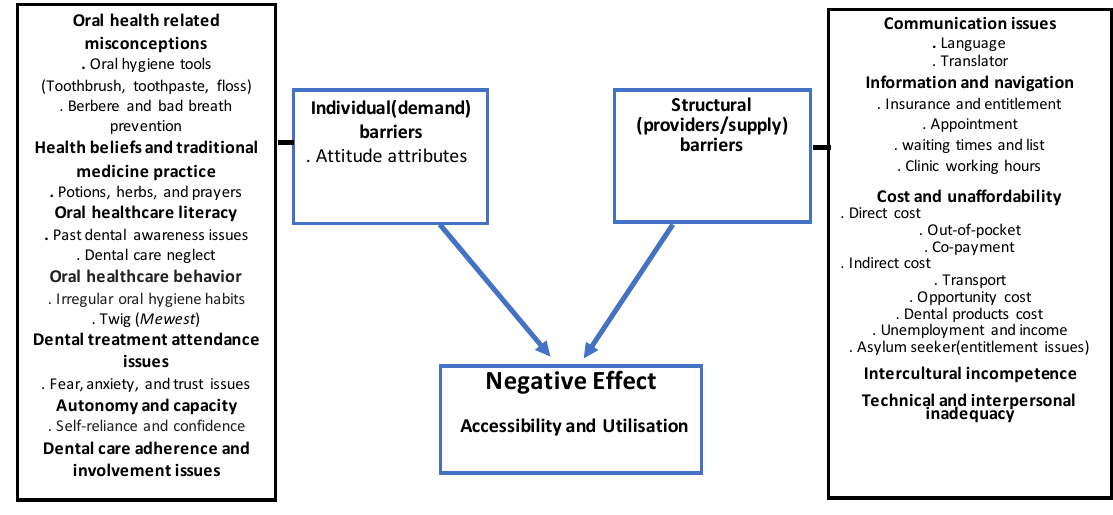
Figure 2. The effect of individual and structural barriers on oral healthcare accessibility and utilization of ERNRAS.